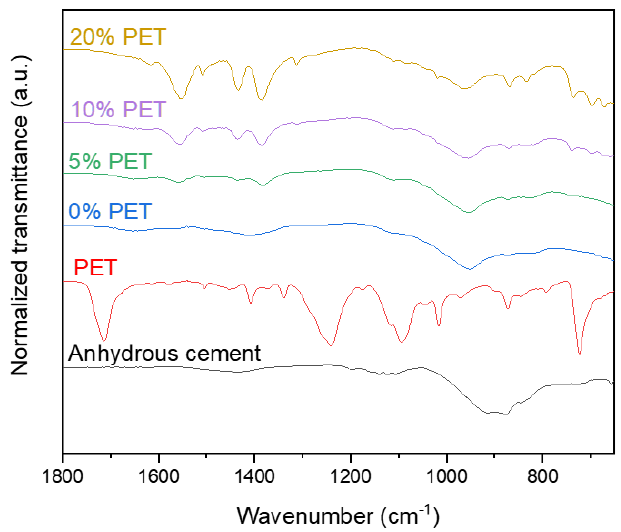
Figure 9. FT-IR spectra of samples incorporating PET